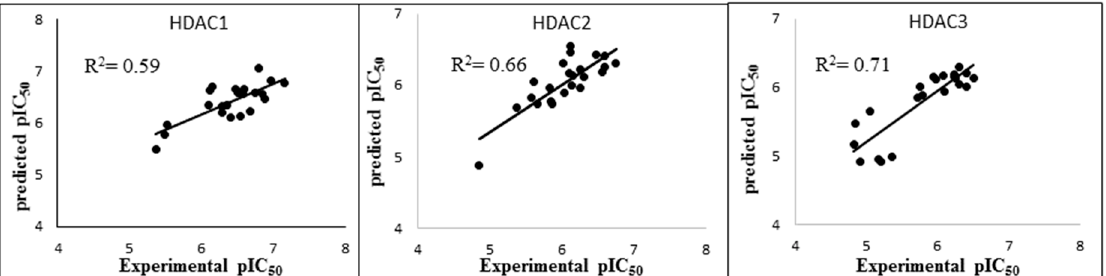
Figure 6. The correlation plots of the best binding free-energy models showing correlation between the predicted data and experimental data for each HDAC subtype.